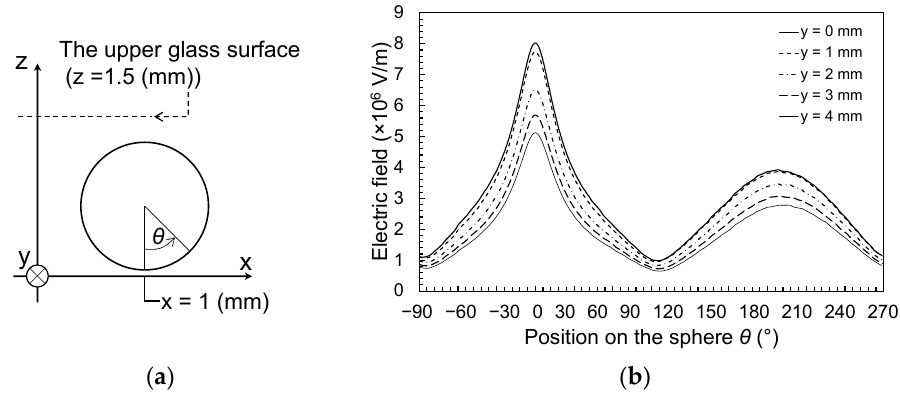
Figure 10. Magnitude of the electric field on the glass sphere: ( a ) Definition of the position where electric field strengths are indicated; ( b ) The magnitude of electric field on the sphere when the sphere center is at x = 1 mm and y = 0–3 mm.